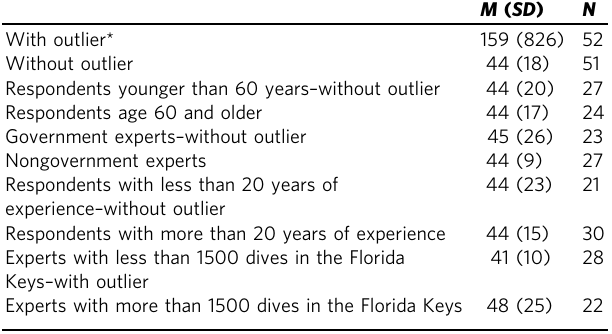
Table 2 Pearson ’ s correlation coef fi cients ( r ) and levels